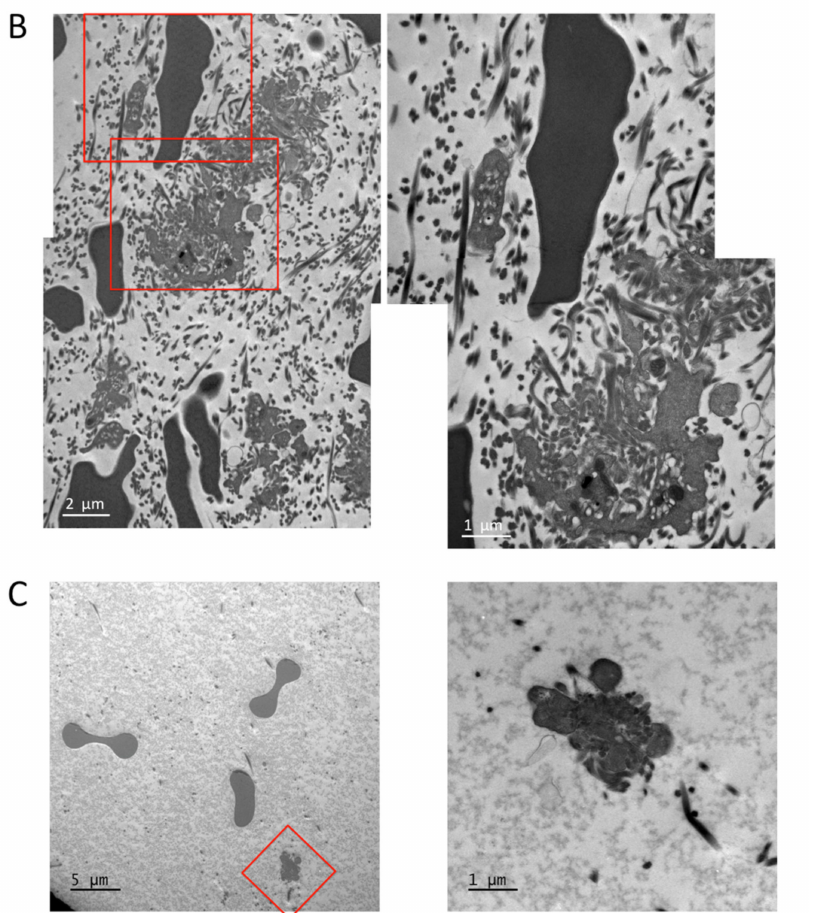
Figure 6. Transmission electron microscopy of clot sections. ( A ) Overview of clot sections, left panel (red arrows indicate undeformed erythrocytes closer to the clot center), and enlargement of the clot periphery as indicated by the red rectangle, right panel (red circle indicates a typical platelet cut approximately in its center; red ellipse indicates a typical compressed erythrocyte cut approximately in its center). ( B ) Enlargement of periphery, left panel, and higher magnification of the same image as indicated by the red rectangles. ( C ) Enlargement of the clot center, left panel, and higher magnification of the same image as indicated by the red